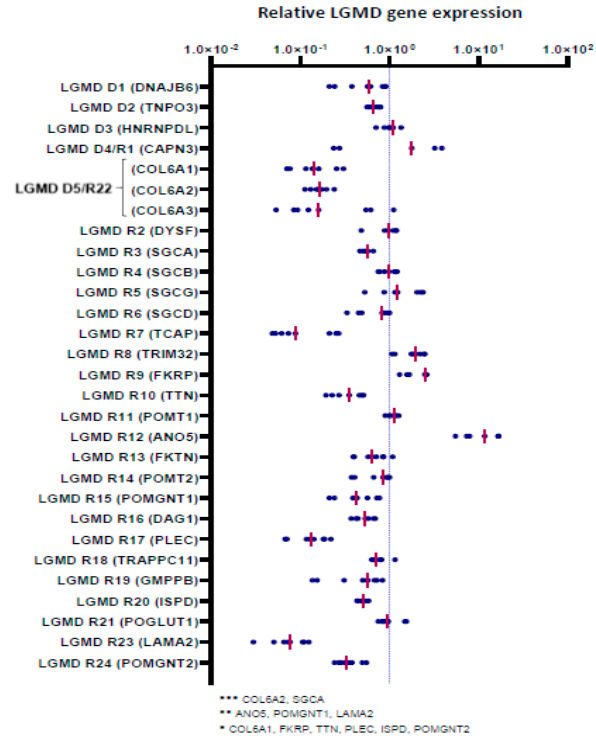
Figure 3. Gene expression analysis of LGMD genes in skMt. Gene expression analysis of LGMD genes in skMt derived from three healthy hiPSC lines (WT1,2,3) at day 7 of myotube maturation. Fold changes (on log 10 scale) for ∆∆ CT, relative to myotubes derived from four healthy primary myoblast cell lines (C25, AB678, AB1079, AB1167), are plotted as a group of data points and orga- nized by gene according to the last revised LGMD classification. The pink horizontal line in each group of data points represents the mean for the group; * 0.01 < p ≤ 0.05 or ** 0.005 < p ≤ 0.01 or *** p < 0.005. Abbreviations: ANO5 , anoctamin 5; CAPN3 , calpain 3; COL6 , collagen 6; DAG1 , dystrogly- can 1; DNAJB6 , DnaJ heat shock protein family member B6; DYSF , dysferlin; FKRP , fukutin-related protein; FKTN , fukutin; GMPPB , GDP-mannose pyrophosphorylase B; HNRNPDL , heterogeneous nuclear ribonucleoprotein D-like; ISPD , isoprenoid synthase domain-containing protein; LAMA2 , laminin subunit alpha 2; PLEC , plectin; POGLUT1 , protein O-glucosyltransferase 1; POMGNT , pro- tein O-linked mannose N-acetylglucosaminyltransferase; POMT , protein O-mannosyltransferase; SGC , sarcoglycan; TCAP , titin-cap; TNPO3 , transportin 3; TRAPPC11 , trafficking protein particle complex subunit 11; TRIM32 , tripartite motif-containing 32; TTN , titin. glycans (SGCB, SGCD, and SGCG), while the alpha subunit (SGCA) was not detected in skMt. Analysis of sarcomeric components showed positive expression and localization within sarcomeres of calpain-3 (CAPN3), telethonin (TCAP), and titin (TTN), while a more